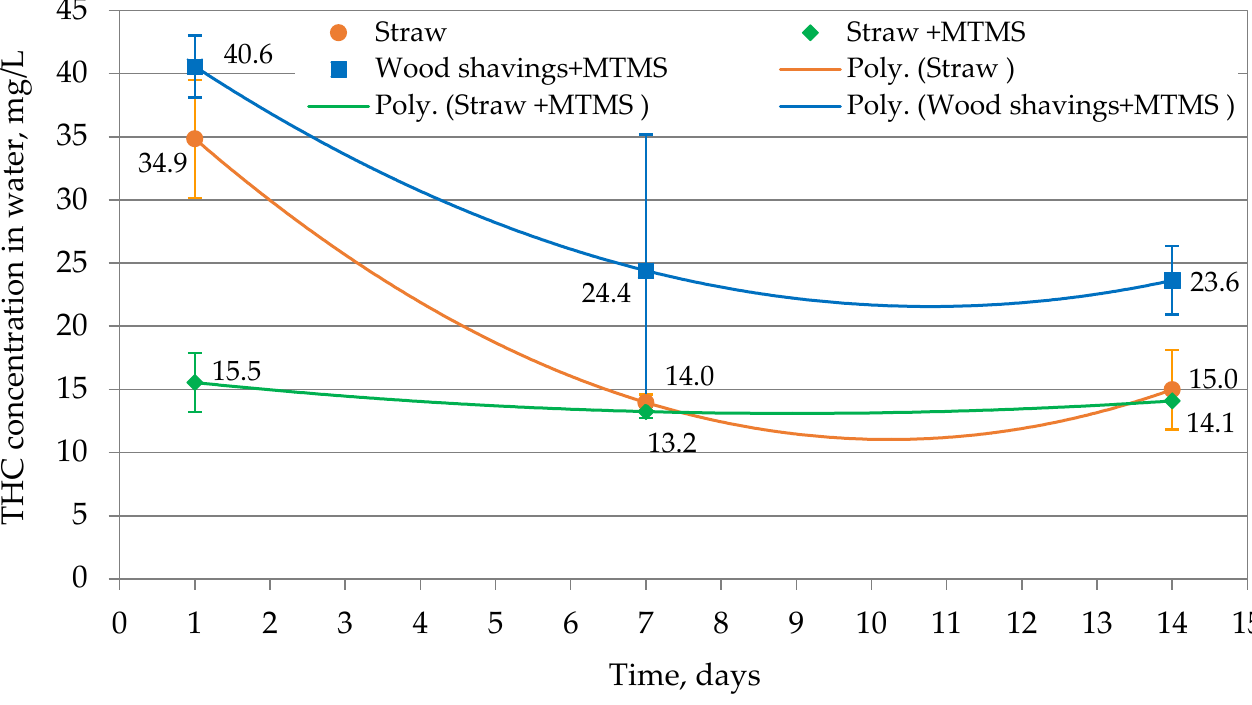
Figure 6. Dynamic of dissolving crude oil in sea water. THC concentration of crude oil in water in the presence of the sorbents: straw with and without MTMS treatment and MTMS-treated wood shavings after 1, 7 and 14 days.